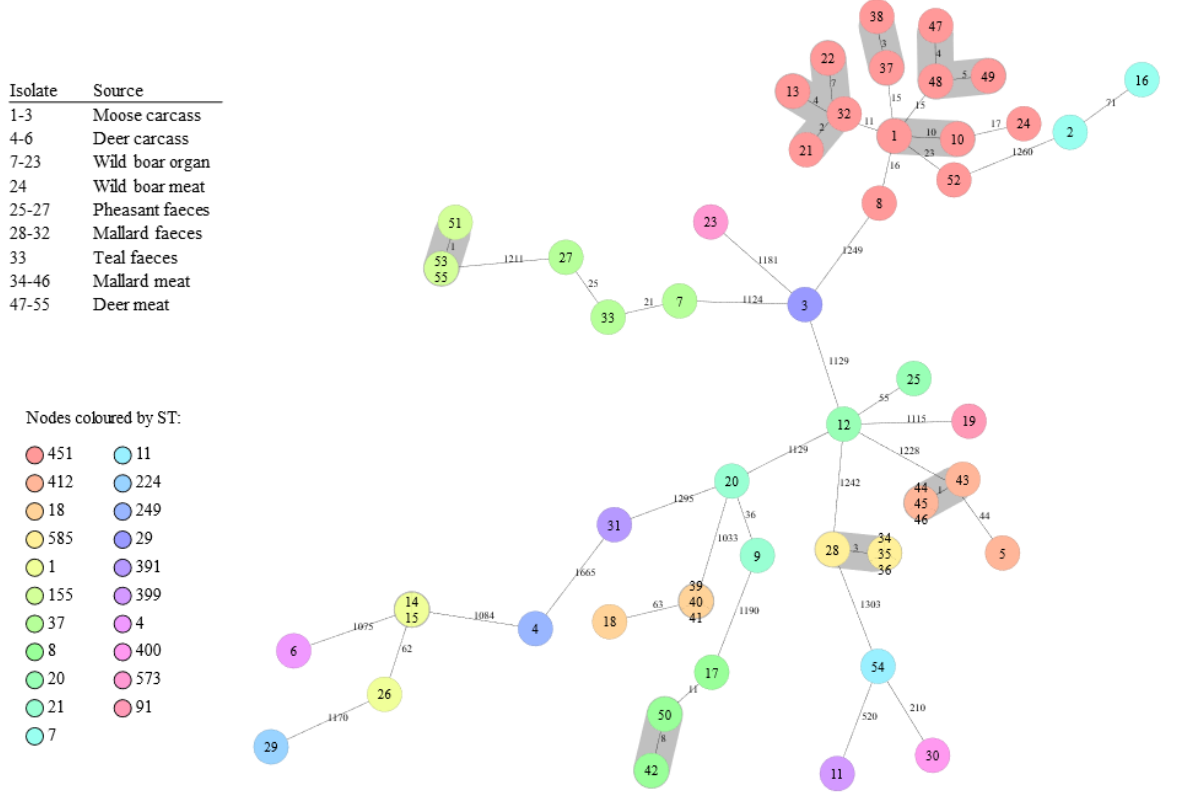
Figure 2. Minimum spanning tree of 55 Listeria monocytogenes isolates from hunted game and game meat in Finland during 2012–2020. The tree was calculated in Ridom SeqSphere+ with 1708 core genome multi-locus sequence typing (MLST) targets and 7-gene MLST targets (pairwise ignoring missing values, logarithmic scale). Nodes are coloured according to sequence type. Number of allelic differences between the isolates are indicated on the connecting lines. Clusters are shaded in grey and a cluster distance threshold of maximum10 was used according to Ruppitsch et al. [29].